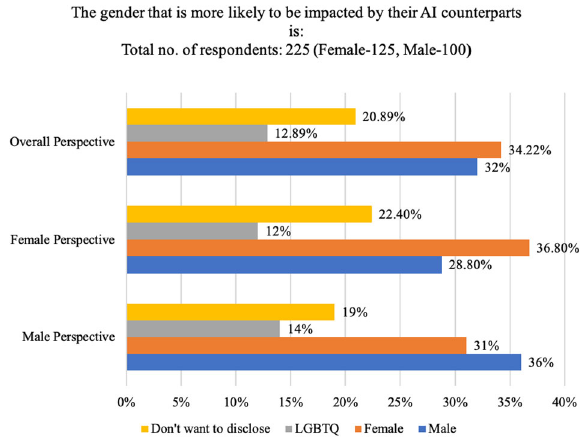
Fig. 11 The gender that is more likely to be impacted by their AI counterparts. Total no. of respondents: 225 (Female: 125, Male: